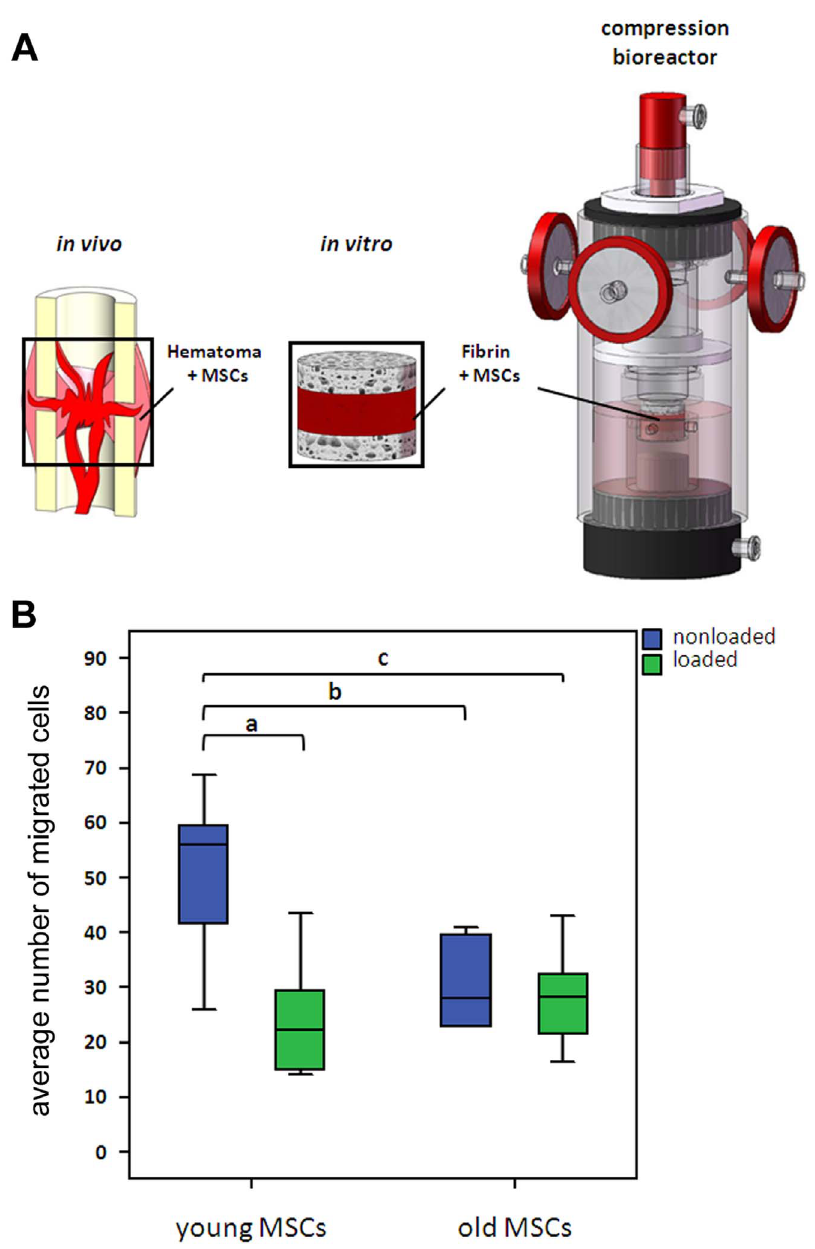
Figure 5. Migration of mechanically stimulated young and old MSCs. (A) Experimental set-up to investigate the effect of mechanical loading of MSC/fibrin constructs. MSCs were embedded in fibrin, placed between two cancellous bone chips and mechanically stimulated. (B) MSC migration was investigated in a modified Boyden-Chamber assay. The average number of migrated cells from five microscopic fields per filter was analysed using NIH ImageJ software. (young MSCs, n=10; old MSCs, n=6, a, p , 0.001; b, p=0.005; c,